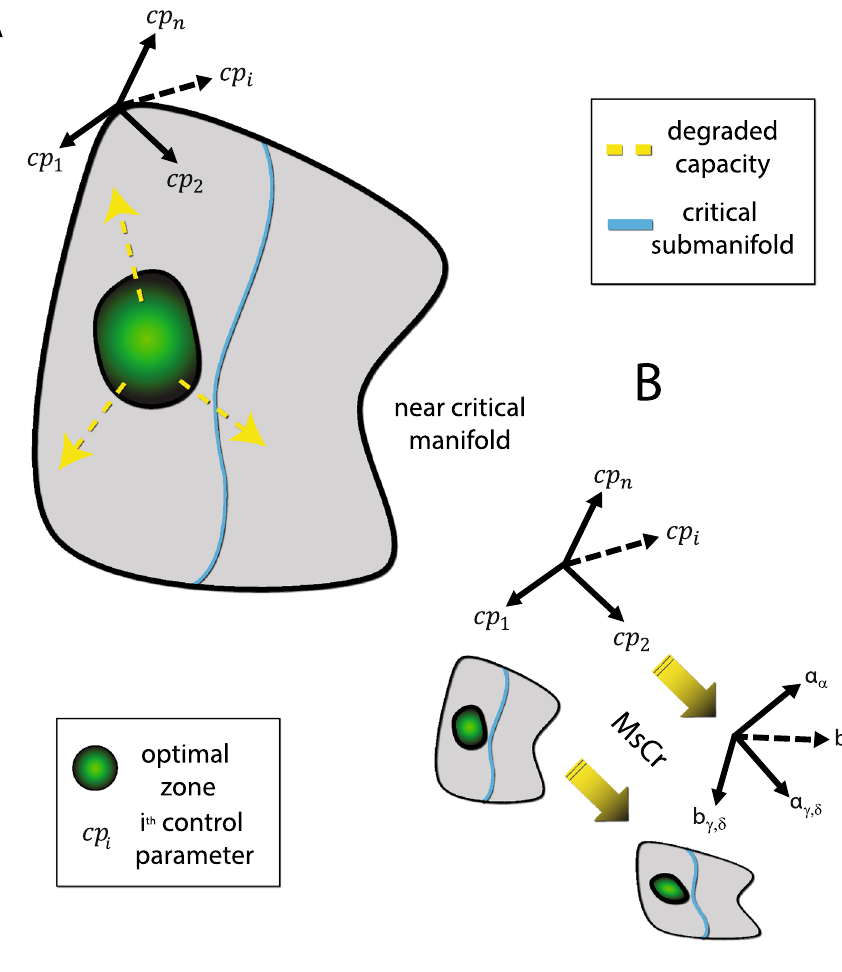
Figure 6. MsCr parameters as bridging constructs between network composition and macroscopic behavior. ( A ) Healthy alert brains are optimally situated with respect to information processing in terms of